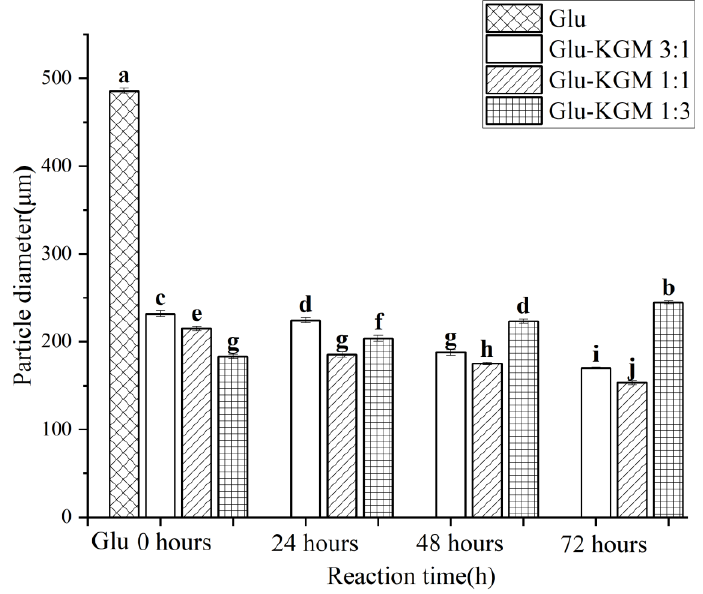
Figure 3. Particle size distribution diagram of gluten, mixtures, and conjugates, respectively. The results with different letters were significantly different ( p < 0.05).